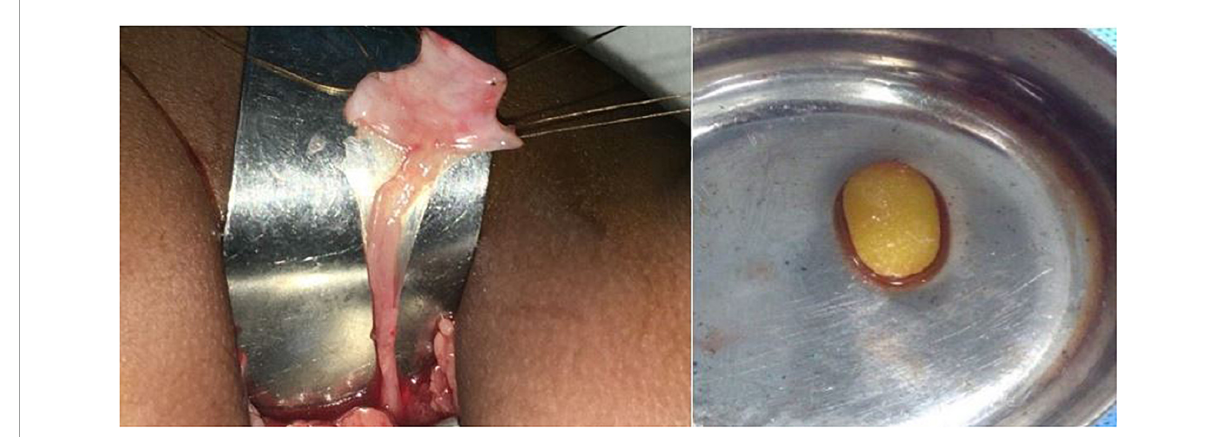
FIGURE3 Intra-operative picture showing valve causing narrowing of the ureteropelvic junction with retrieved calculus.